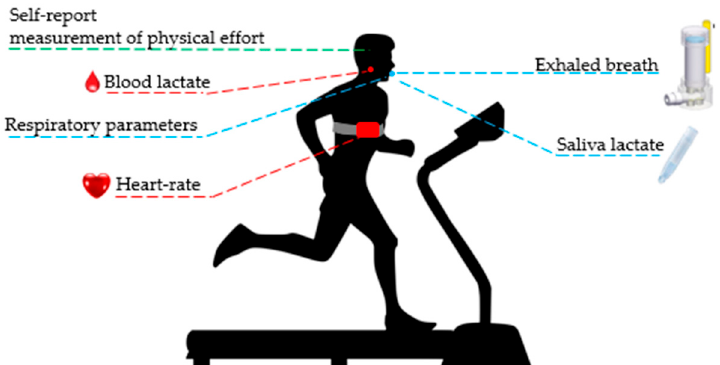
Figure 2. The athlete is running on a treadmill; Respiratory parameters and heart rate are real-time monitored. During the pause between the steps, lactate from blood and saliva samples are evaluated; at the beginning and at the end of the test as well. An exhaled breath sample is also collected.